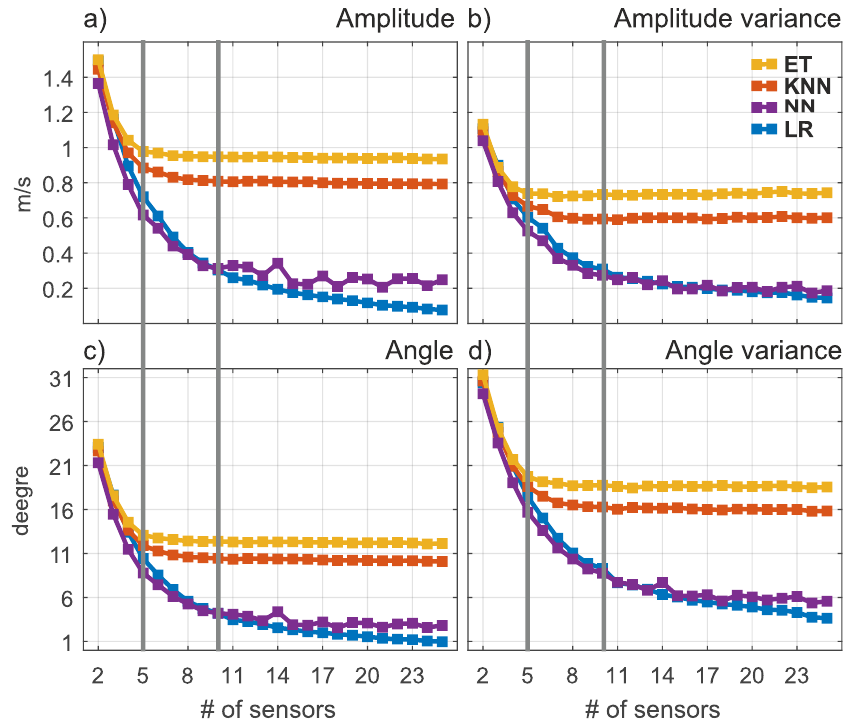
Figure 4. The average amplitude and angular error (subfigures a , c ) and their variances (subfigures b , d ) for different number of sensors. The gray line indicates experiments (f) and